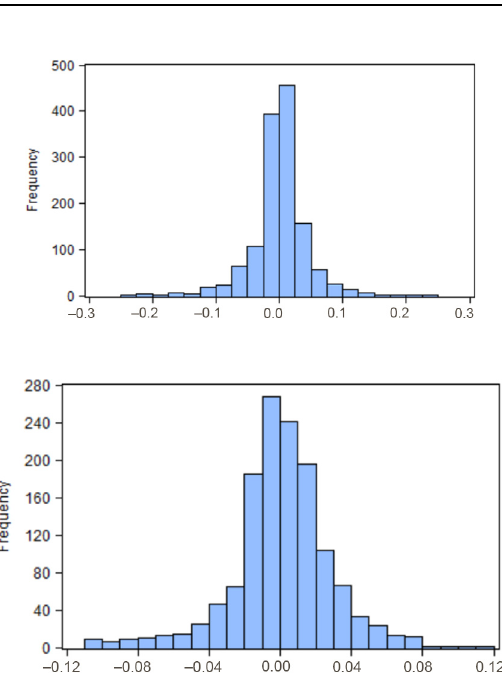
Figure 4. Histogram